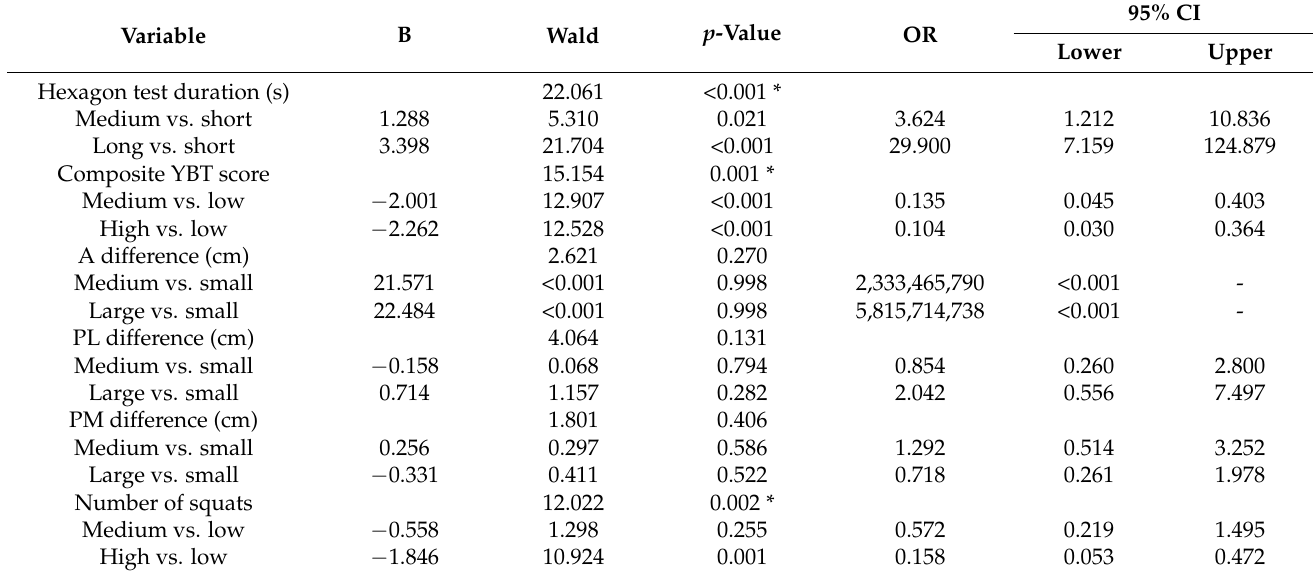
Table 4. Univariate binary logistic regression results.